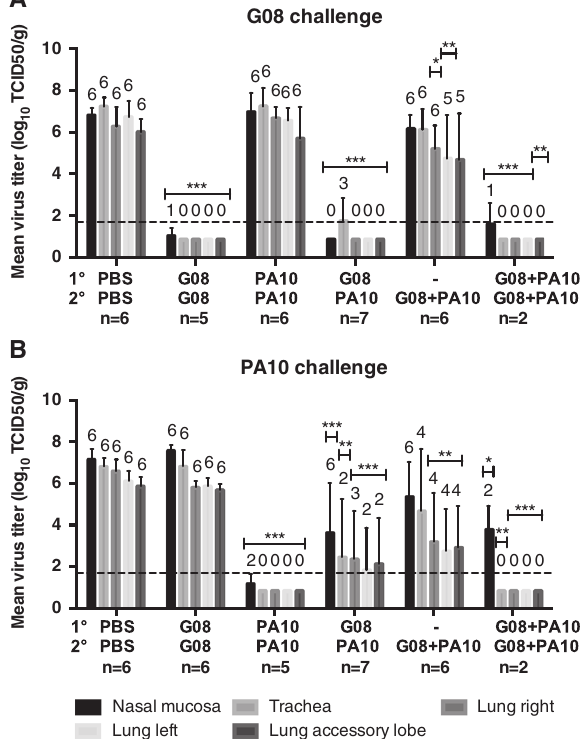
Fig. 3 Heterologous prime-boost vaccination with G08 and PA10 protects against challenge with either one of both vaccine strains. Pigs were challenged intranasally with 10 7 TCID 50 of G08 ( a ) or PA10 ( b ) 1 month after the booster vaccination or after the single vaccination in the bivalent vaccine (1x) group. They were euthanized 3 days after the challenge, and virus titers were determined in samples of the nasal mucosa, trachea and three different parts of the lung. Bars represent mean virus titers ± SD. Dotted lines indicate the limit of detection. Numbers along the x-axis represent the number of pigs challenged with G08 or PA10 in each group. Numbers on top of the bars indicate the number of pigs with detectable viral titers. Asterisks indicate signi fi cantly reduced virus titers as compared to the mock-vaccinated challenge control group in ANOVA. * P < 0.05, ** P < 0.01, *** P < 0.001. The normal distribution was assessed by the Shapiro-Wilk test. Statistically signi fi cant reductions of the number of virus-positive pigs were observed upon G08 challenge in the G08 homologous prime-boost ( P < 0.05 for nasal mucosa and P < 0.01 for other samples, Fisher ’ s exact test) and heterologous prime-boost groups ( P < 0.001, all samples except trachea) and upon PA10 challenge in the PA10 homologous prime- boost ( P < 0.01, all samples except nasal mucosa) and heterologous prime-boost groups ( P < 0.05, all samples except nasal mucosa). A signi fi cant reduction was also observed in the bivalent vaccine (2x) group for trachea and lung samples ( P <